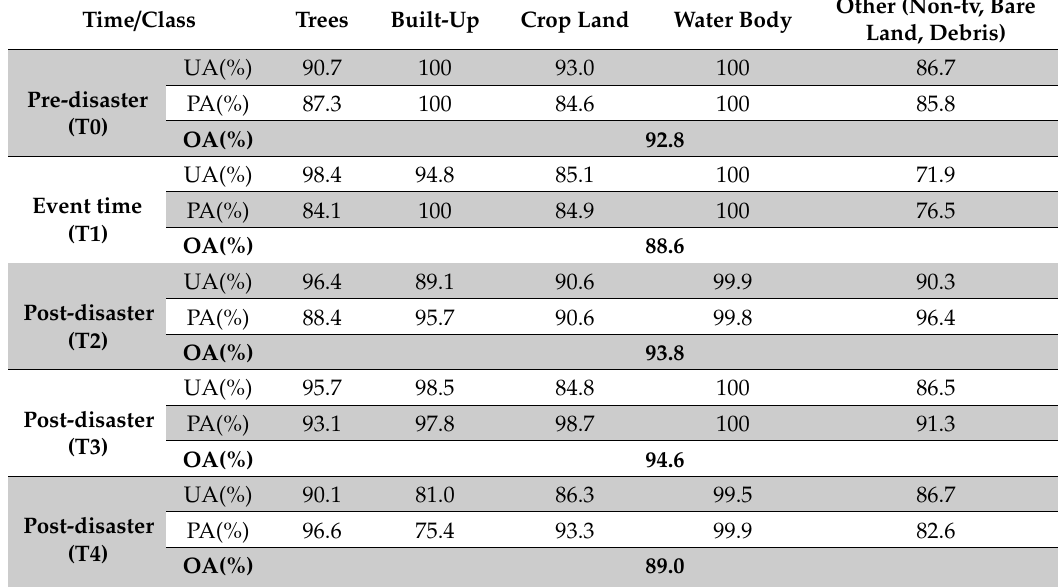
Table 3. The land cover classification accuracies for T0, T1, T2, T3, and T4 time epochs for Leyte